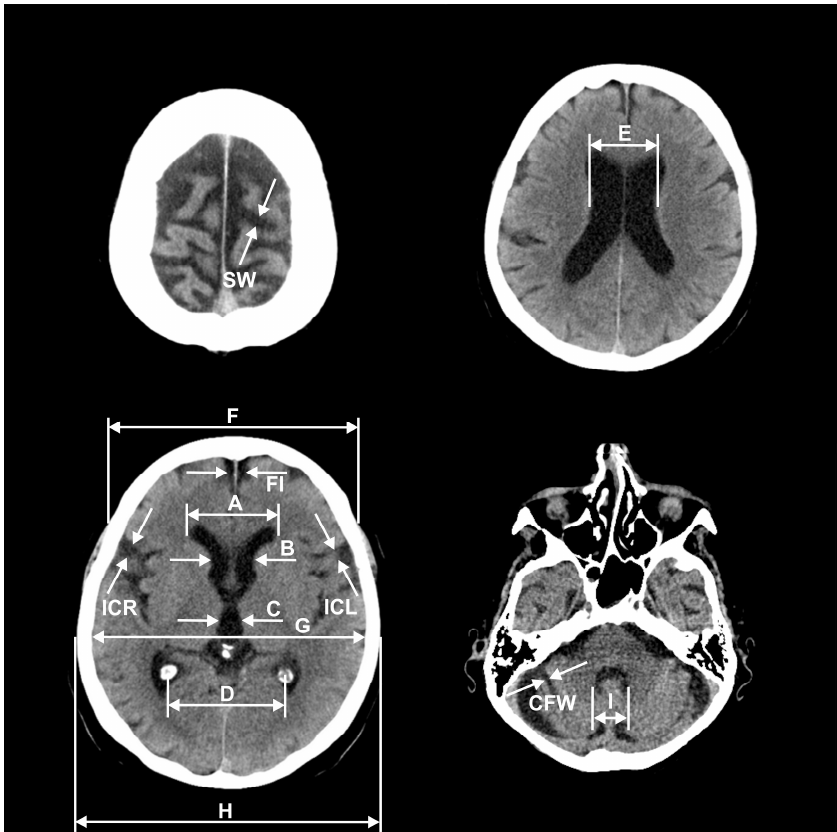
Figure 1. Measurements of brain atrophy parameters: A, B, C, D, E, F, G, H, I, FI, ICR, ICL, SW, CFW in CT images.